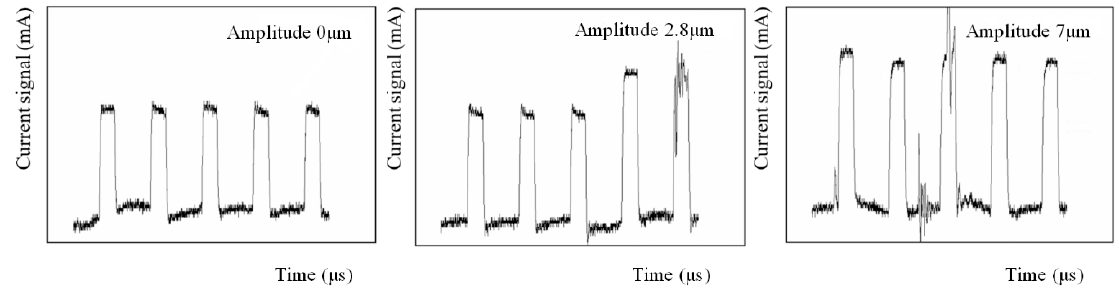
Figure 12. Current waveforms under different vibration amplitudes.